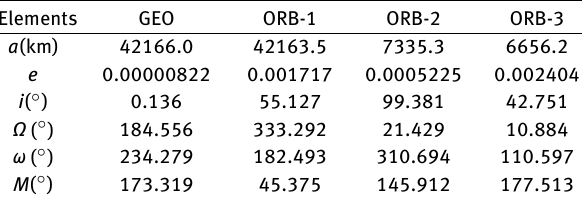
For a NCEO on ORB-2, the average position error was 27.69 km when the SMR changed by a factor of 0.1. The position error became 280.25 km when the SMR changed by a factor of 10. When the SMR changed by a factor of 100, the position error sharply increased and the average error was 3344.03 km (See Figure